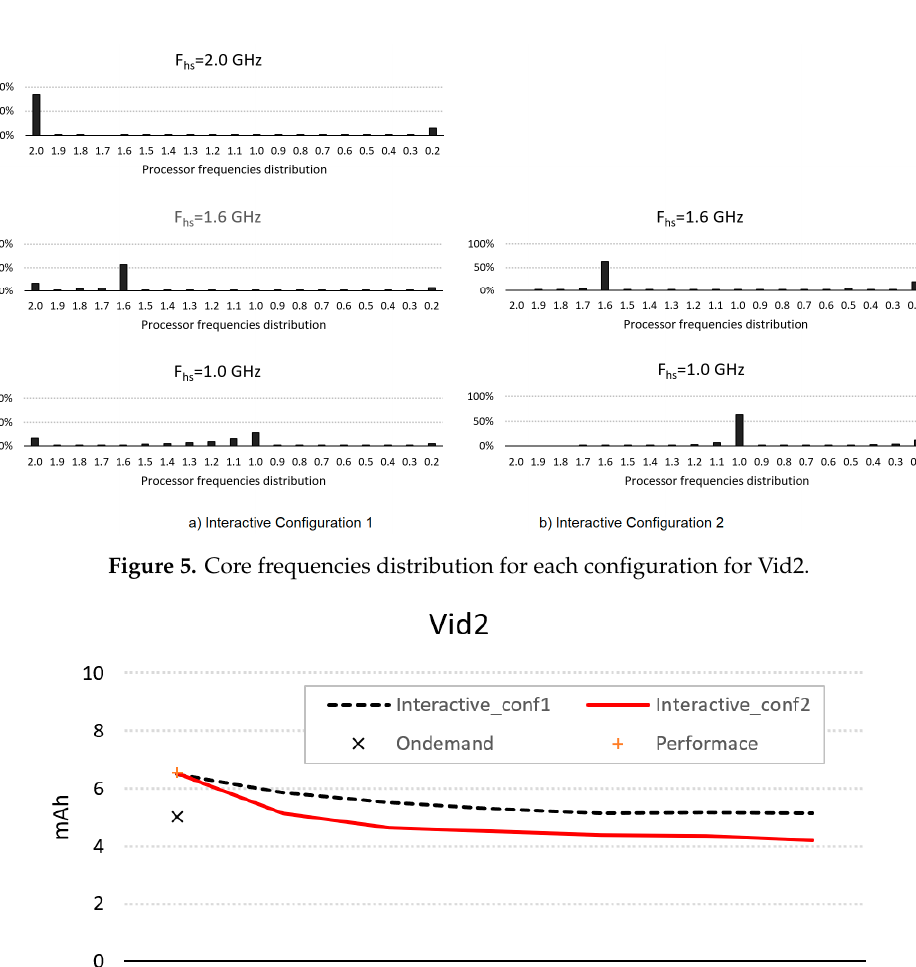
Table 9. Performance and OnDemand governors with F max . Vid1.